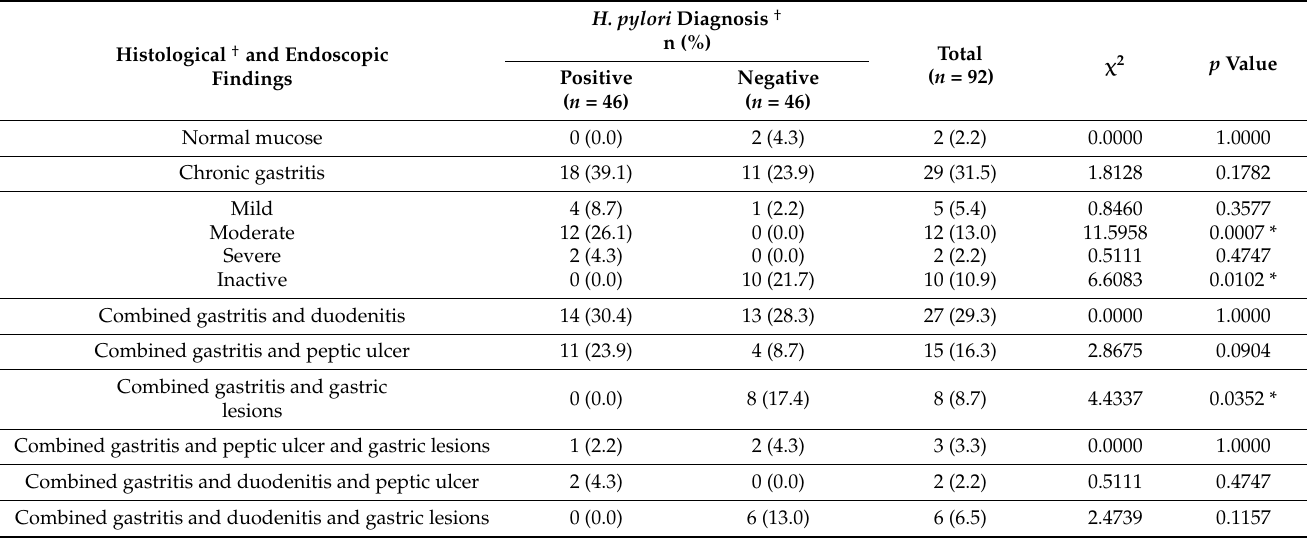
Table 2. H. pylori infection status according to gastroduodenal diseases diagnosed by endoscopic and histopathological examination among the study population ( n =